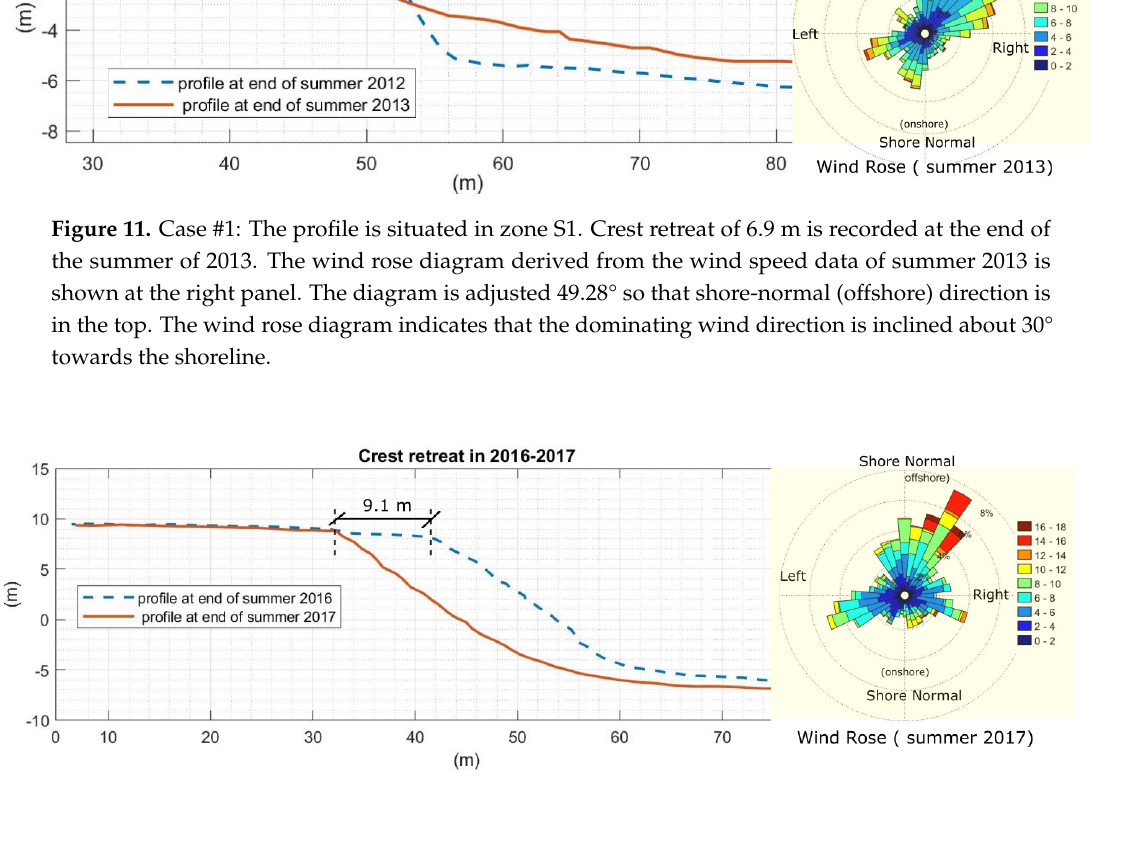
Figure 12. Case #2: The profile is situated in zone S2. Crest retreat of 9.1 m is recorded from the end of the summer of 2017. The wind rose diagram of summer 2017 (adjusted to the shore-normal(offshore) position) indicates, dominating wind direction is the same as that of summer 2013. However, the wind speed is considerably higher for Case